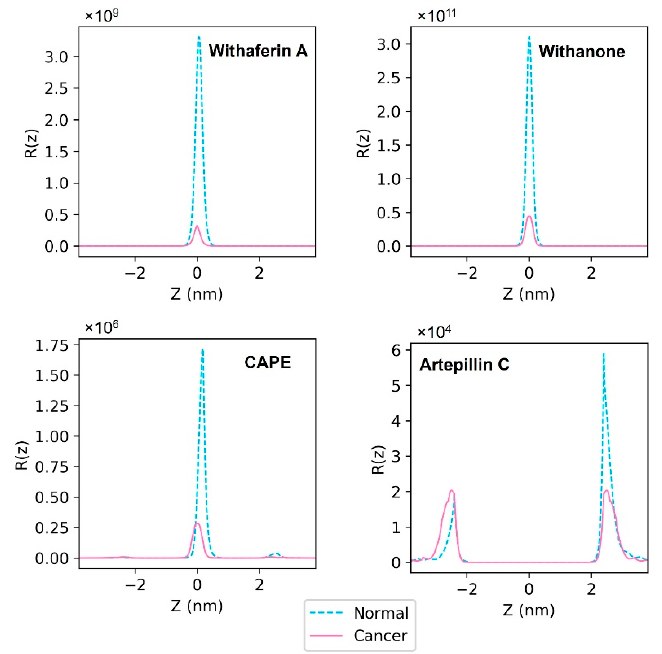
Figure 7. Resistivity profiles of Withaferin A (Wi ‐ A), Withanone (Wi ‐ N), Caffeic Acid Phenethyl Ester (CAPE) and Artepillin C (ARC). The solid magenta line indicates the resistivity profile in the cancer cell membrane model and the dashed cyan line indicates the resistivity profile in the normal cell membrane model. On the horizontal axis, the value 0 indicates the center of the hydrophobic core of the membrane, negative values indicate the outer (extracellular) leaflet and positive values indicate the inner (cytoplasmic) leaflet. Table 2. Calculated permeability coefficients of the drug molecules. Note: XLOGP3 ‐ AA indicates the computed octanol–water partition coefficients retrieved from the Pubchem database.